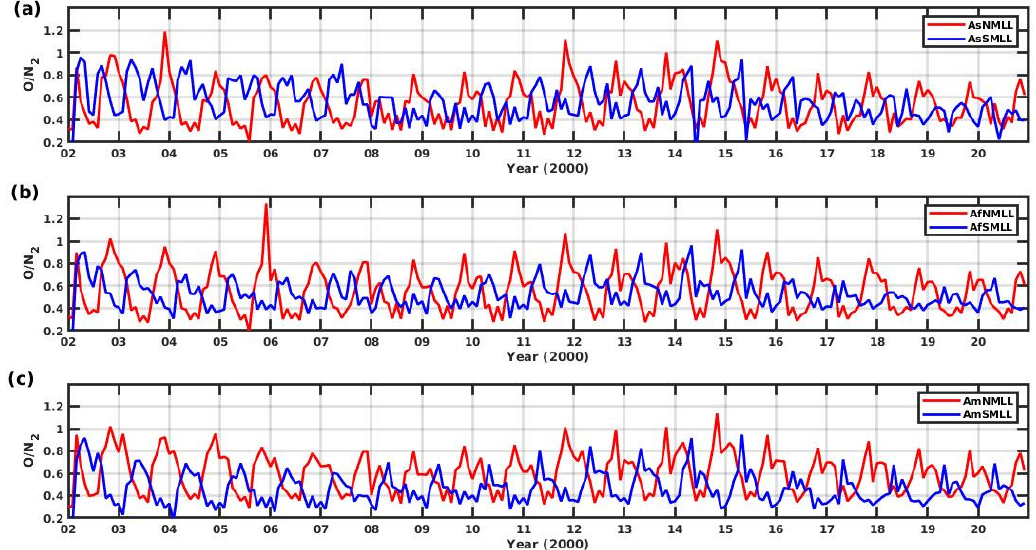
Figure 7. Similar to Figure 1b for ( a ) Asian, ( b ) African, and ( c ) American regions.